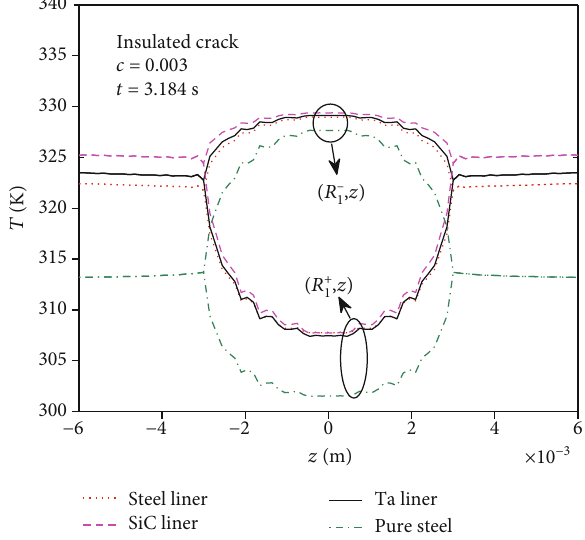
Figure 5: E ff ect of liner material on the temperature distribution along the interface